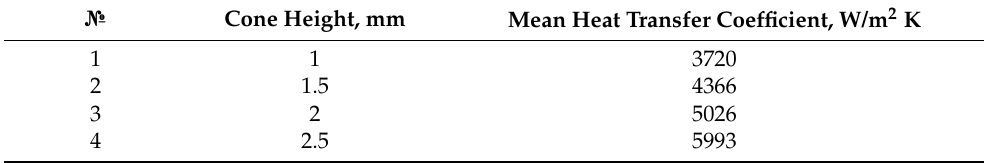
Table 4. Average values of heat transfer coefficient.